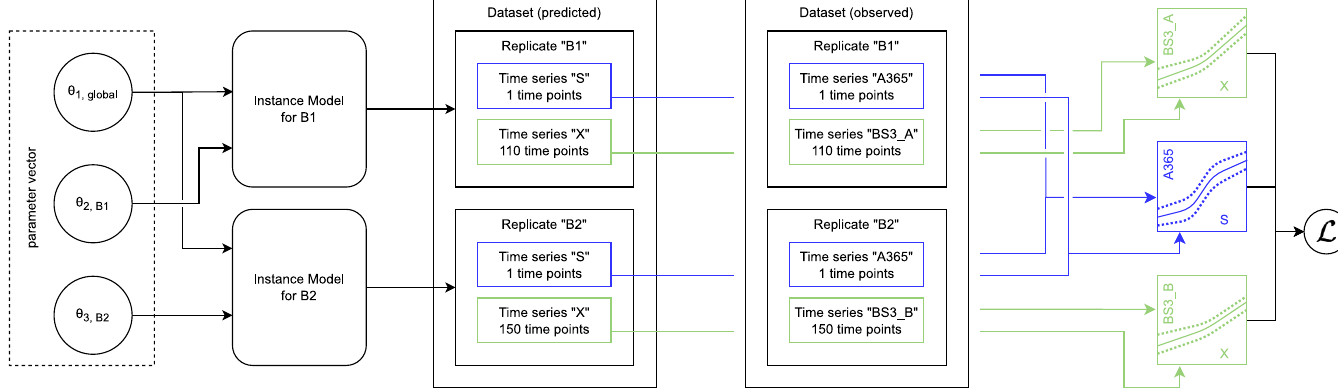
Fig 7. Data structures and computation graph of murefi models. Elements in a comprehensive parameter vector are mapped to replicate-wise model instances. In the depicted example, the model instances for both replicates “B1” and “B2” share θ 1,global as the first element in their parameter vectors. The second model parameter θ 2 is local to the replicates, hence the full parameter vector (left) is comprised of three elements. Model predictions are made such that they resemble the structure of the observed data, having the same number of time points for each predicted time series. An objective function calculating the sum of log-likelihoods is created by associating predicted and observed time series via their respective calibration models. By associating the calibration models based on the dependent variable name, a calibration model may be re-used across multiple replicates, or kept local if, for example, the observations were obtained by different methods.